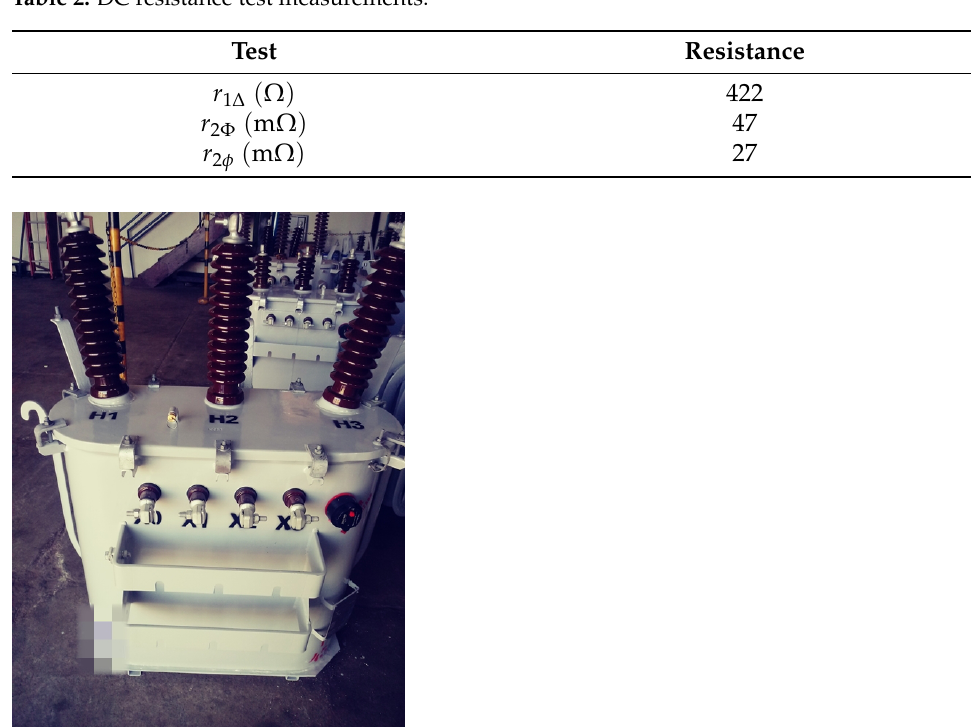
Table 2. DC resistance test measurements.